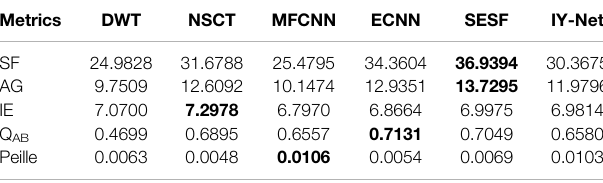
TABLE 5 | Quantitative evaluation results of remote sensing image fusion. Metrics DWT